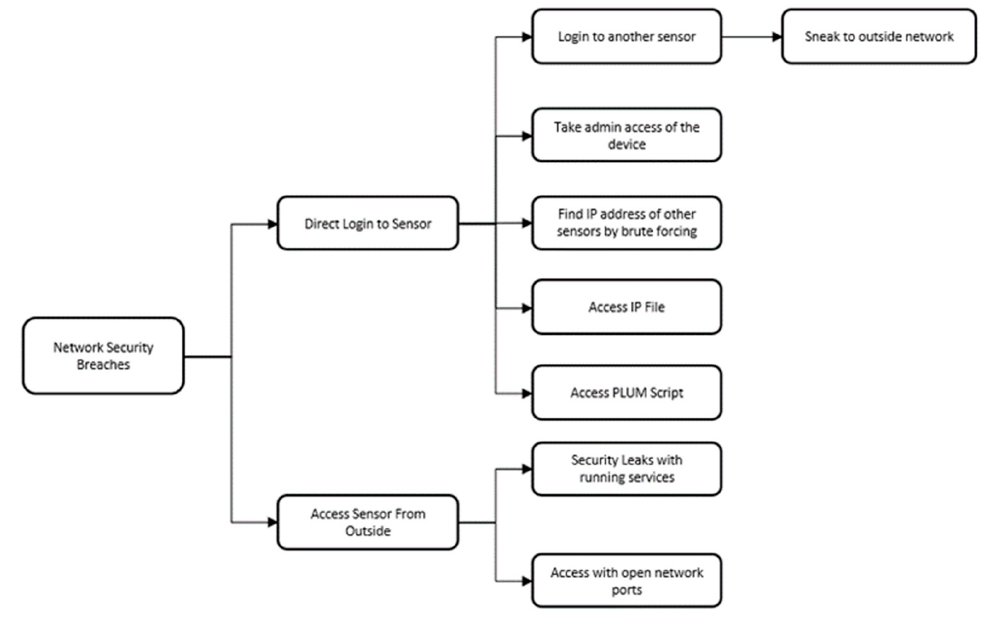
Figure 3. Different types of possible security breaches in the proposed network architecture.